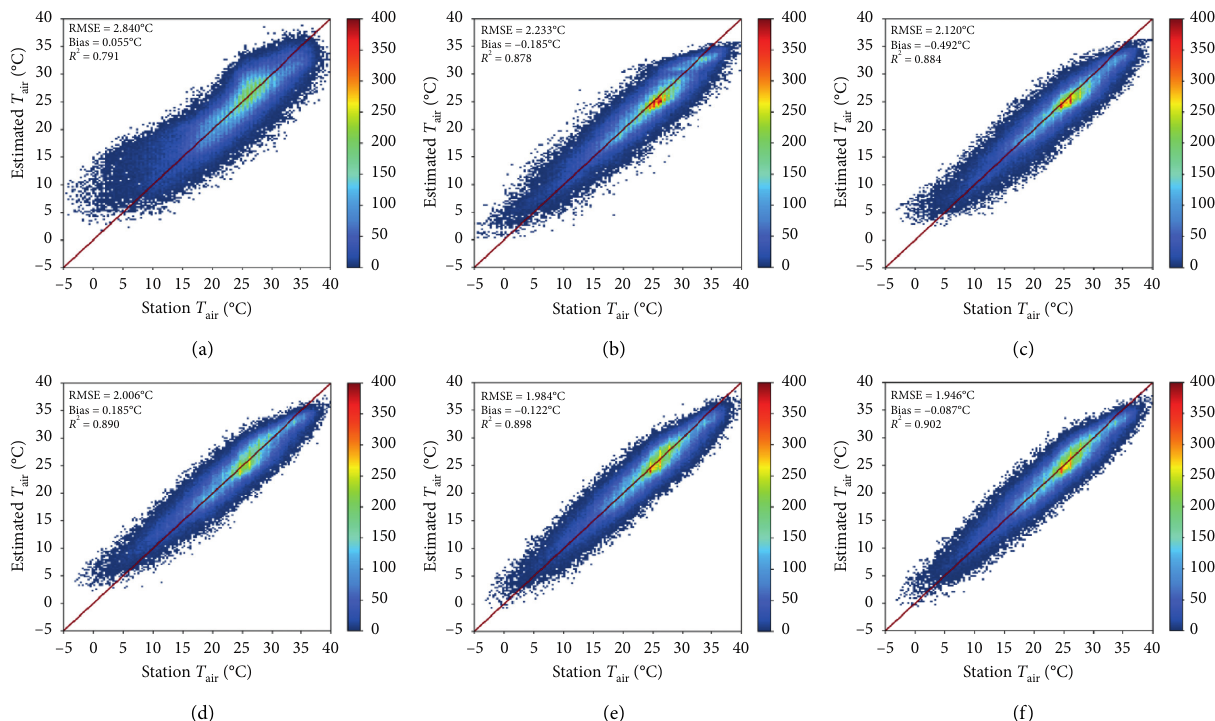
Figure 6: Two-dimensional histogram of predicted T air data and meteorological observed T air data based on six machine-learning models. (a) MLR model. (b) RF model. (c) KNN model. (d) DNN model. (e) GBTD model. (f) XGB model.